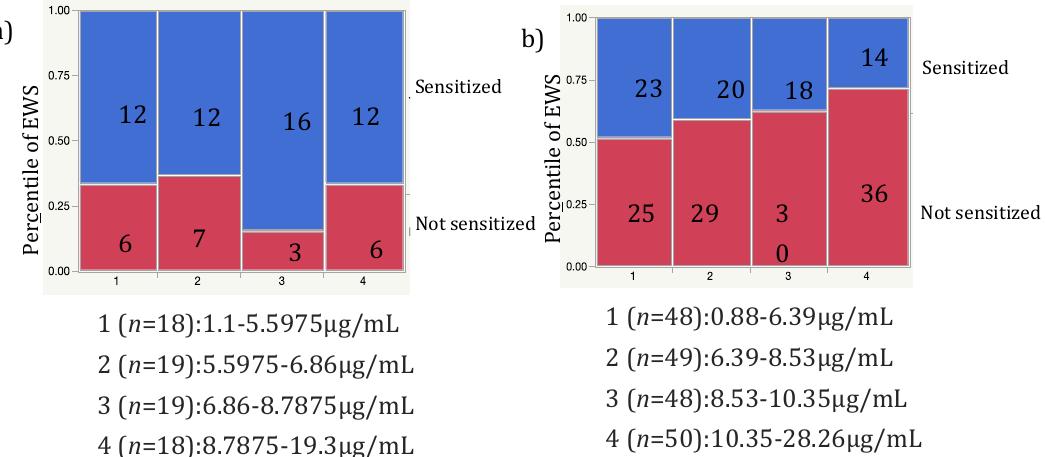
Figure 2. Dose-dependent trend for sCD14 levels in 1-month BM to EWS at 9 months of age in AD ( a ) and non-AD ( b ) infants. EWS decreased significantly with increasing sCD14 levels in 1-month BM in non-AD infants (Cochran–Armitage trend test, p = 0.042).